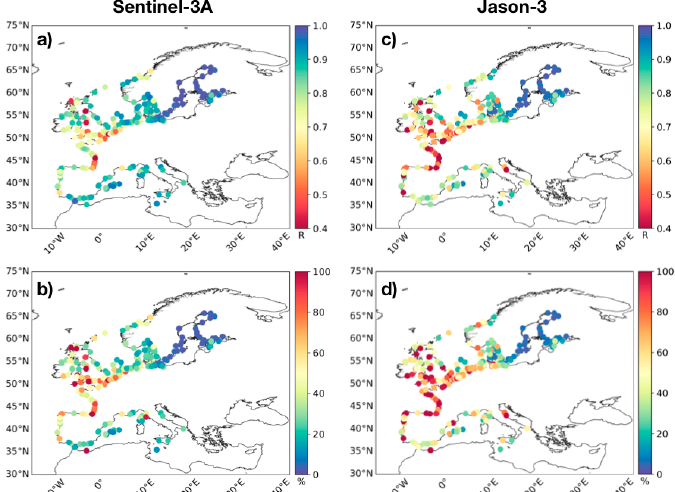
Figure A1. Spatial distribution of the correlations (panels a , c ) and relative variance reduction between tide gauge and SLA [variation(tide gauge–altimeter)]/variation(tide gauge); units are the percent of the tide gauge variance (panels b , d ) for the inter-comparisons between Sentinel-3A (left column) and Jason-3 (right column) with tide gauge time series conducted in the European coasts. Unfiltered SLA and tide gauge stations common to both satellite missions have been used.